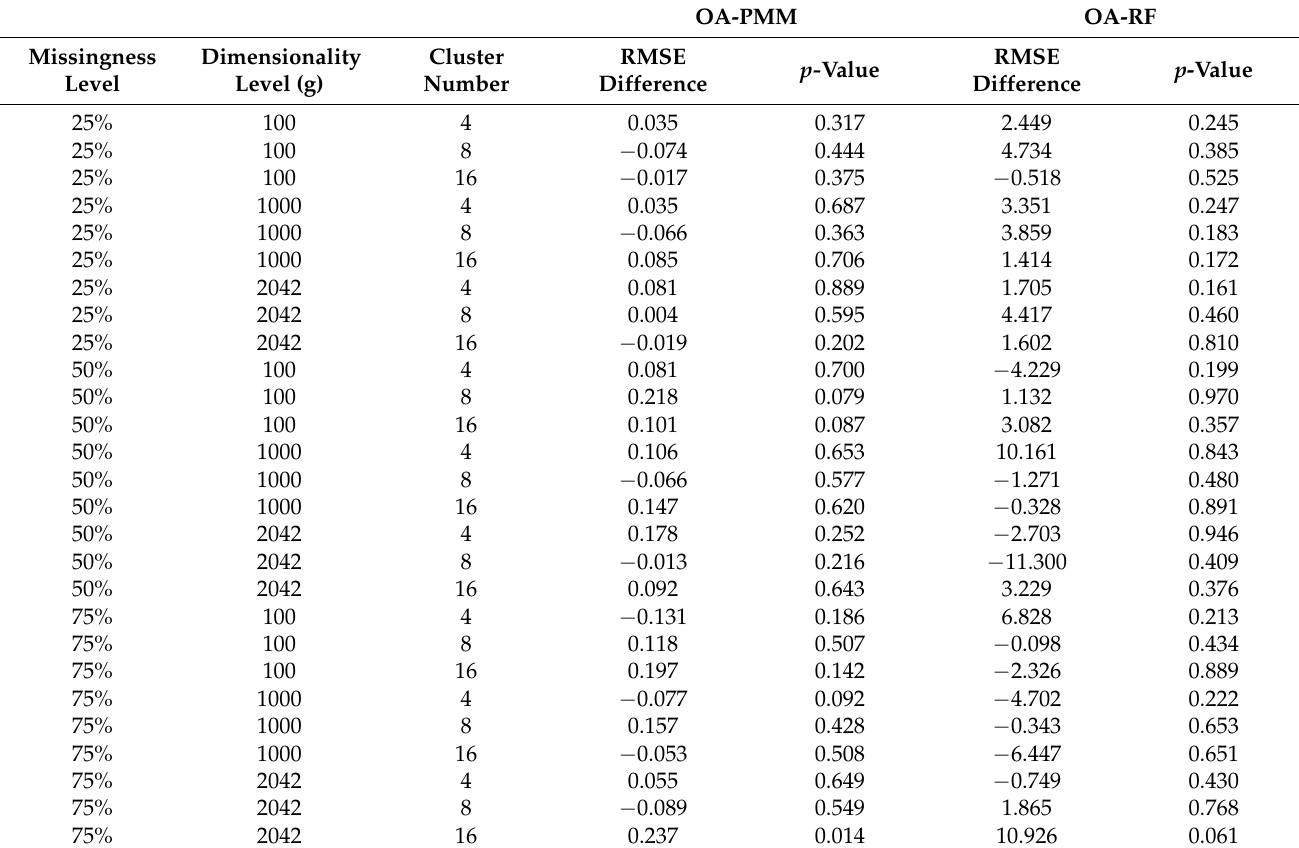
Table A5. The RMSE difference from imputation is applied with and without the integration of comorbidity information for the OA dataset. Negative RMSE correspond to improvement by the hybrid approach. The pmm and rf models in MICE were used in this study. The p -value is reported based on 10